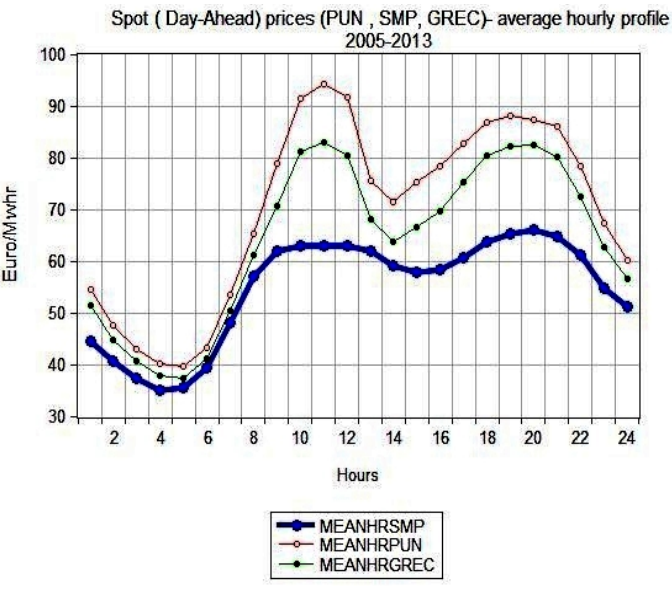
Figure 4. Average hourly profile of Spot DA prices PUN, GREC and SMP, 2005–2013.